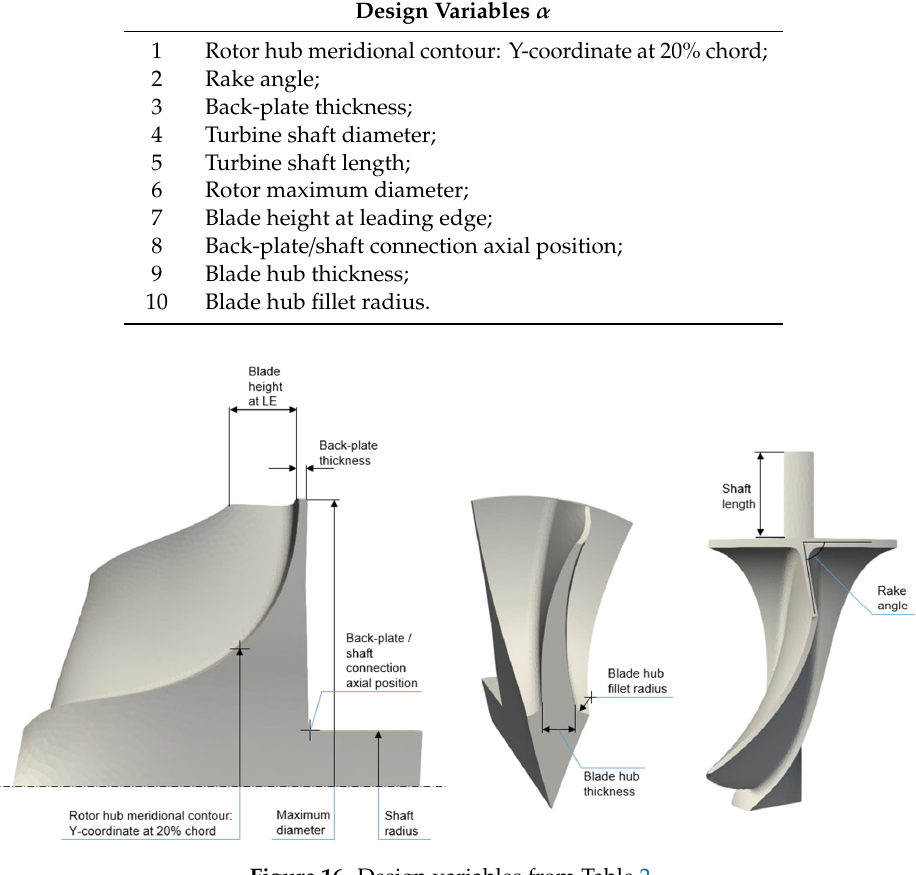
Figure 16. Design variables from Table 2.